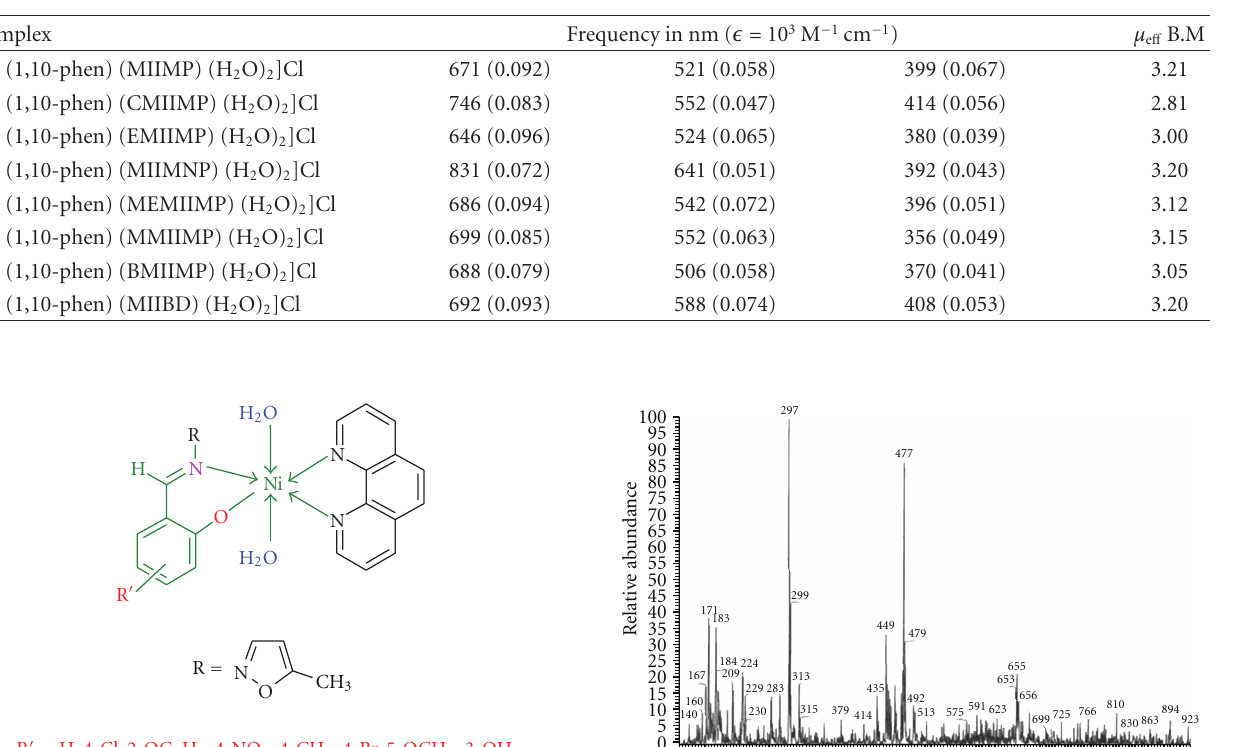
Table 3: Magnetic moments and electronic spectral data for ternary complexes.